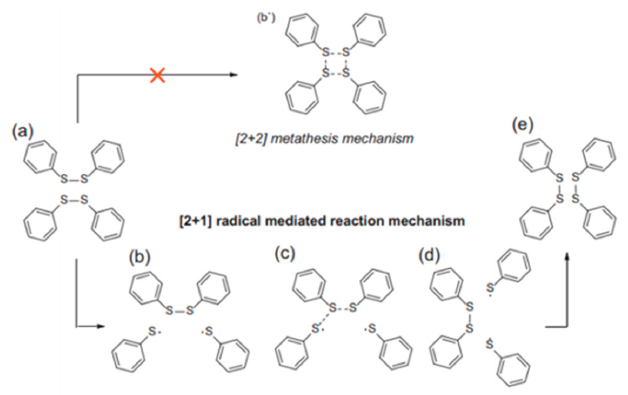
Figure 6. Schematic representation of a [2 + 2] metathesis (above) and a [2 + 1] radical mediated (below) reaction mechanisms